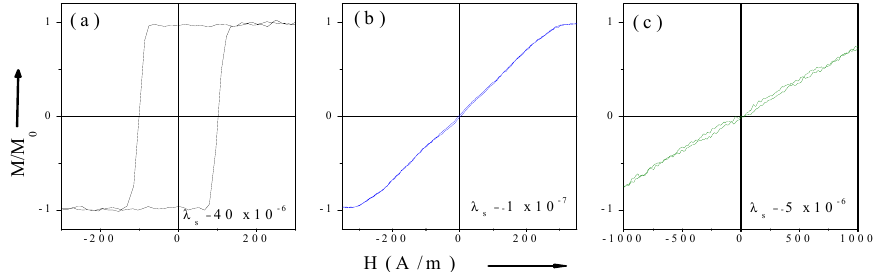
Figure 1. Hysteresis loops of magnetic microwires Fe 75 B 9 Si 12 C 4 with positive ( a ) Co 67.1 Fe 3.8 Ni 1.4 Si 14.5 B 11.5 Mo 1.7 with nearly-zero; ( b ) and Co 77.5 Si 15 B 7.5 with negative ( c ) λ s